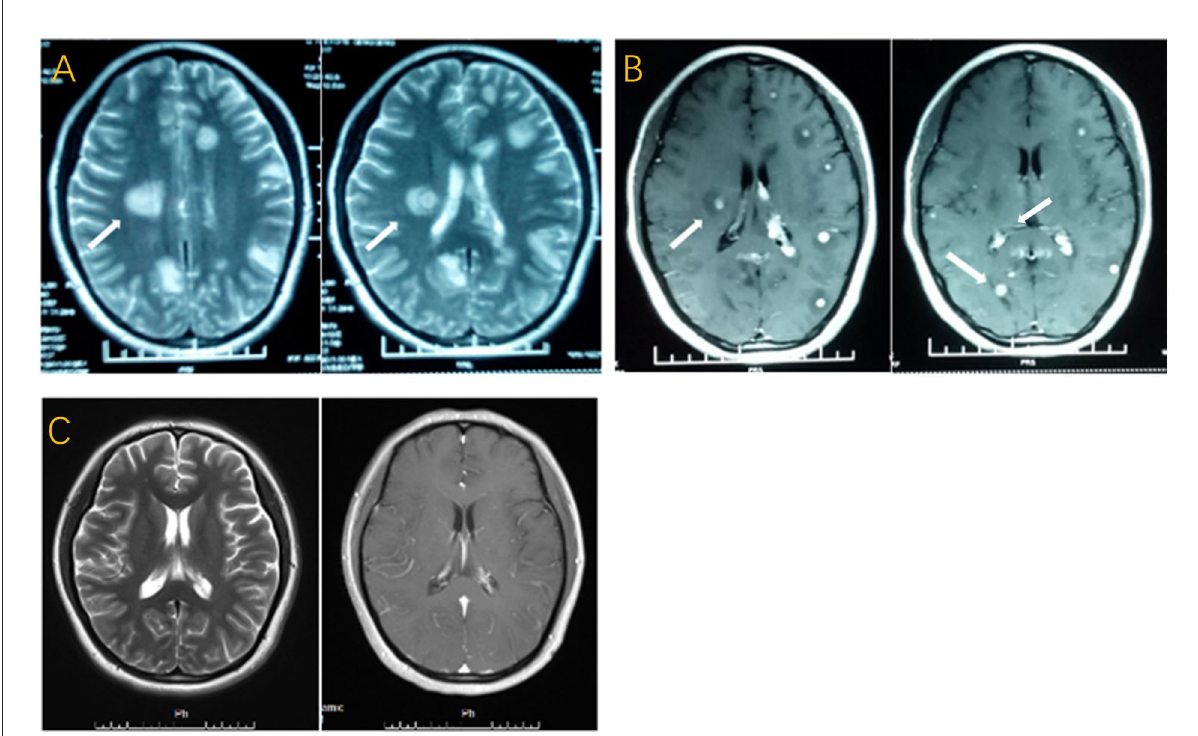
FIGURE1 (A) T2-weighted image with multiple patchy high-intensity signals and “target sign”. (B) T1-weighted post-gadolinium contrast image with multiple nodular lesions and peripheral oedema. (C) T2-weighted image and T1-weighted post-gadolinium contrast image done three months later with approximate disappearance of the